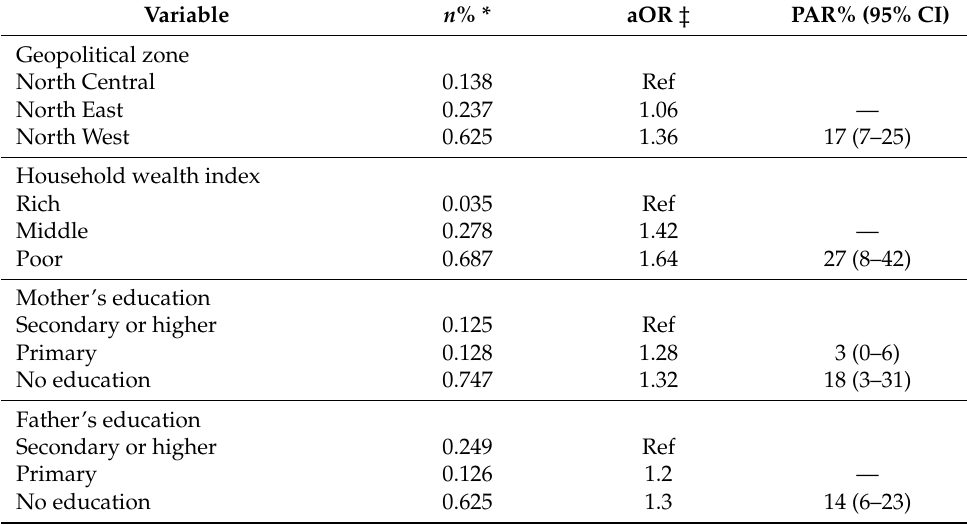
Table 4. Estimated PAR% for each of the factors significantly related to under-5 mortality in the NGZs,